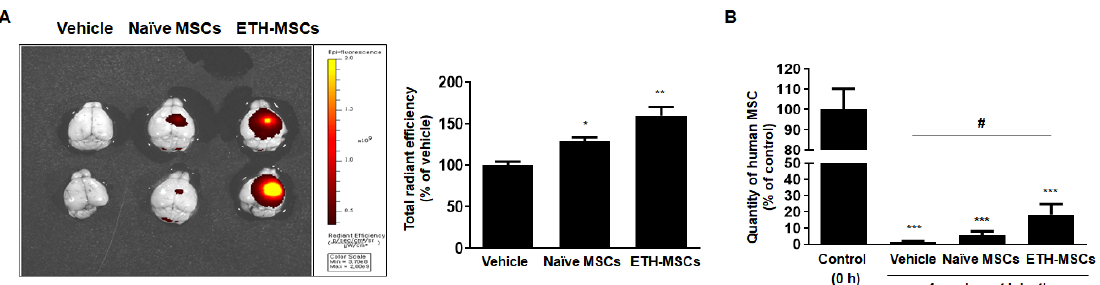
Figure 5. Preconditioning with ethionamide enhanced the survival of MSCs in vivo. The survival rate of MSCs was assessed. ( A ) MSCs were shown by red fluorescence signal of optical imaging ex vivo. ( B ) The quantification of survived MSCs was investigated by qPCR using human-specific Alu primer. Results obtained from three independent experiments are expressed as percentage of control ± SEM; * p < 0.05, ** p < 0.01, and *** p < 0.005 vs. control (0 h). Control (0 h); the brain tissue extracted immediately after MSCs injection. # p < 0.05 vs. vehicle. Vehicle; the media used to resuspend the MSCs for injection .